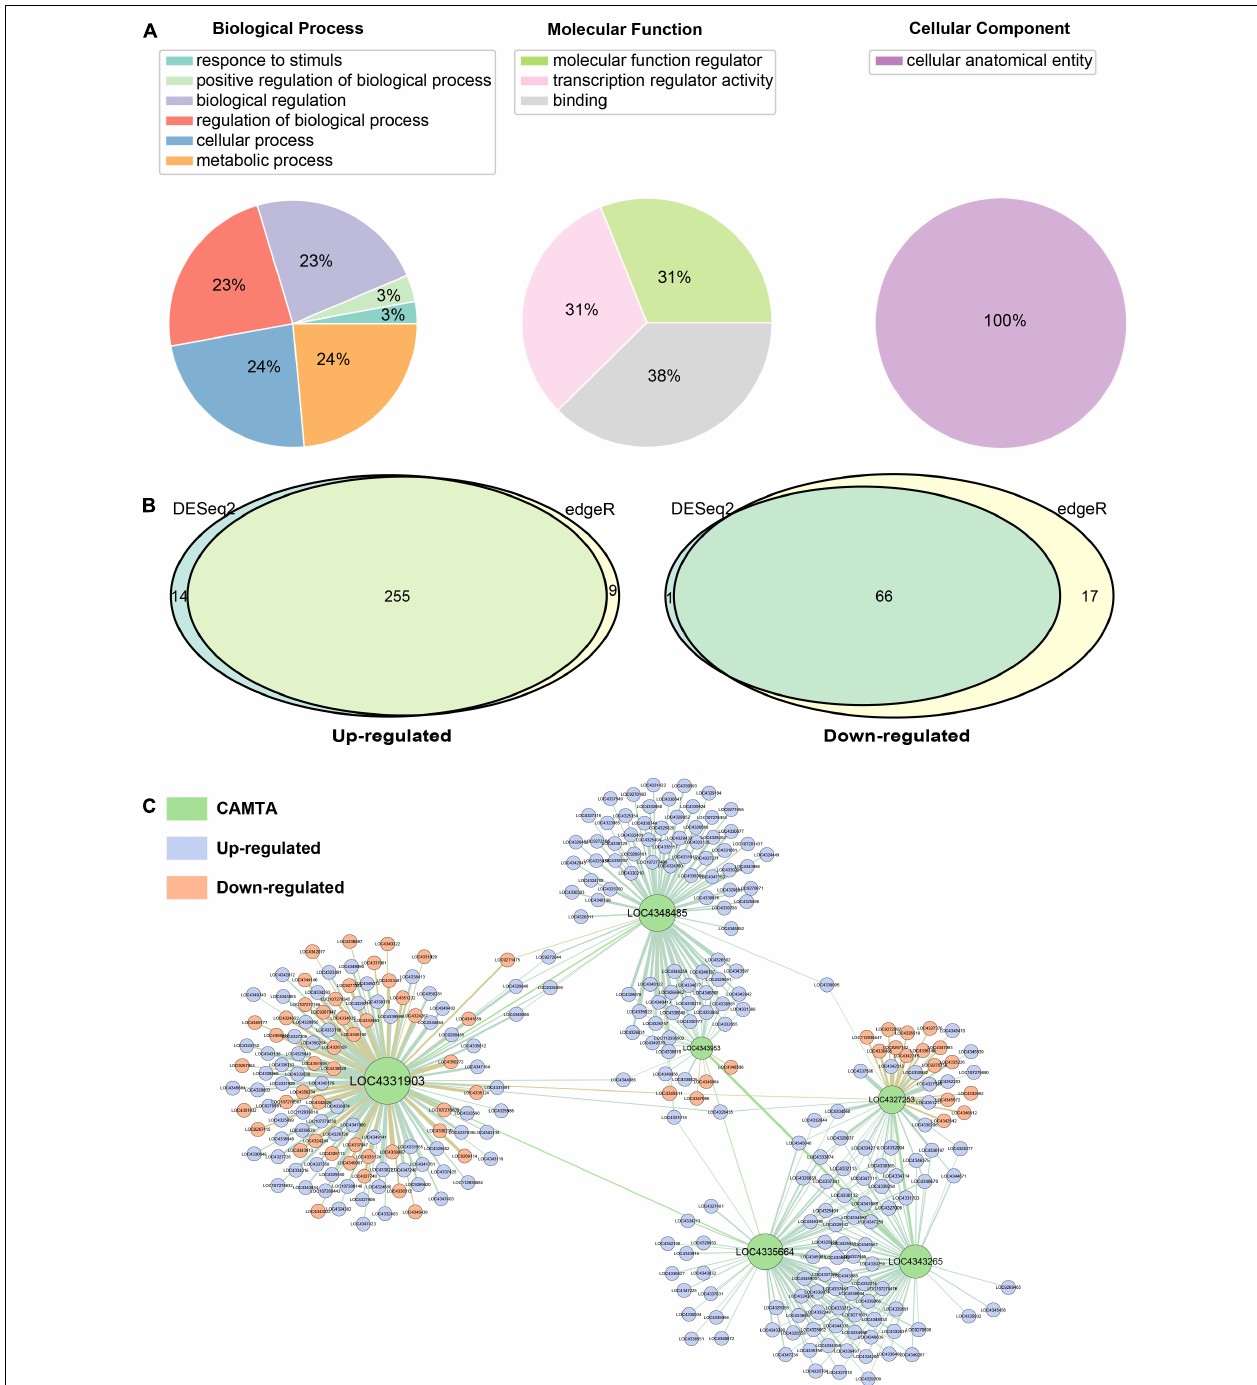
FIGURE 6 | Function analysis of the CAMTA genes. (A) Gene Ontology (GO) analysis of identified CAMTA genes. GO analysis of CAMTA protein sequences mainly in terms of biological process, molecular function, and cellular component. (B) Analysis of differential expression in rice under cold stress by using DESeq2 and edgeR. (C) Regulatory network of CMATA genes in rice under cold